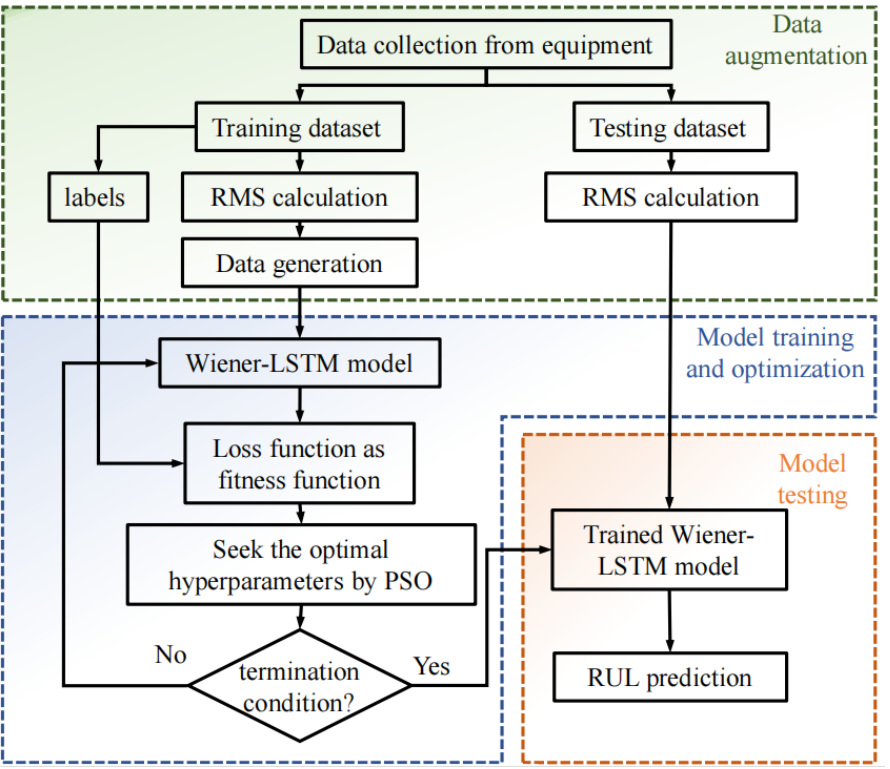
Figure 1. The flowchart of the proposed method. Three stages can be divided in the method. The generated data in the data augmentation process are sent to the training process of the Wiener–LSTM model. What is more, the hyperparameters of the Wiener–LSTM model are optimized by PSO algorithm. At the end, the testing data are sent to the trained Wiener–LSTM model to verify the effectiveness of the proposed